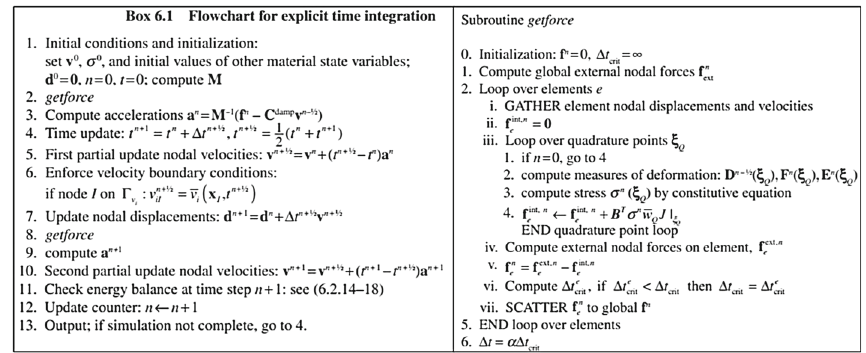
Fig. 3 Explicit time integration flowchart from Nonlinear Finite Elements for Continua and Structures by Belytschko et al. [27]